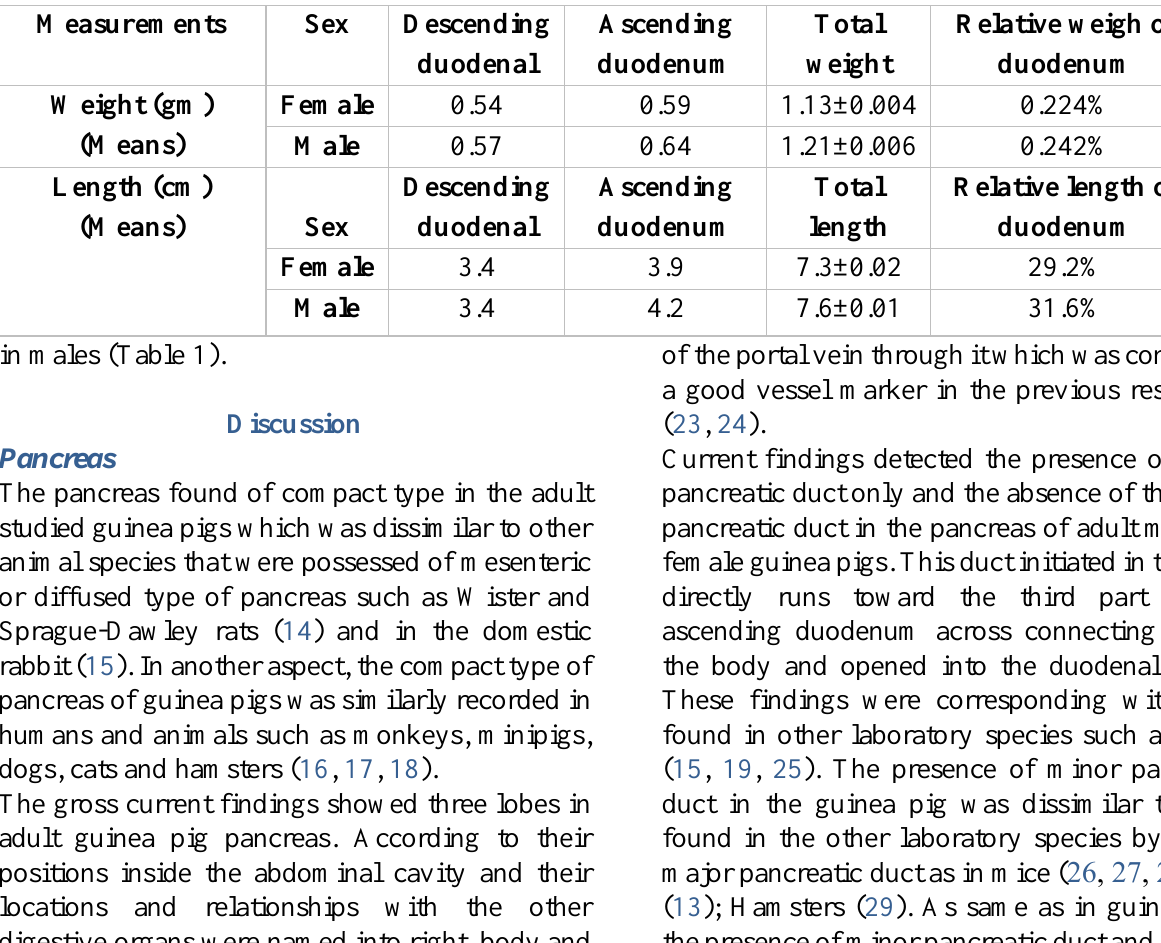
Table 2. Micromorphometric measurements of weights and lengths of descending and ascending duodenum in adult female and male guinea pigs ( Cavia porcellus